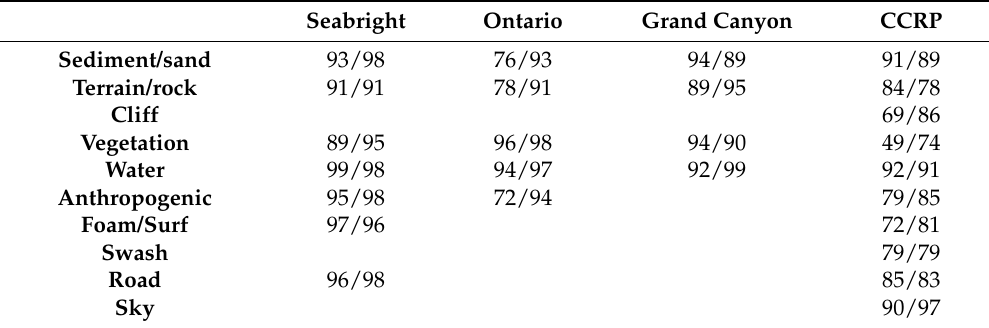
Table 2. Mean whole tile classification accuracies (%), per class, for each of the non-satellite datasets ( T = 96/ T = 224), using the test tile set not used to train the model.